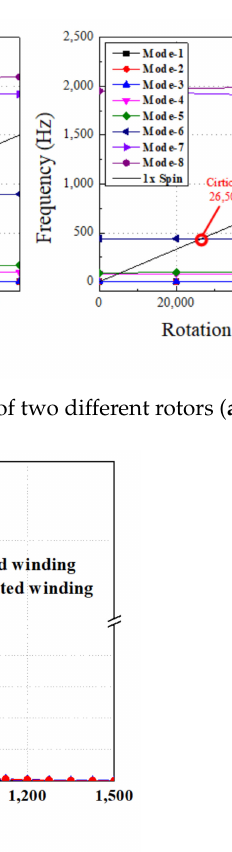
Figure 10. Stress applied to the hollow shaft rotor according to the winding method for each